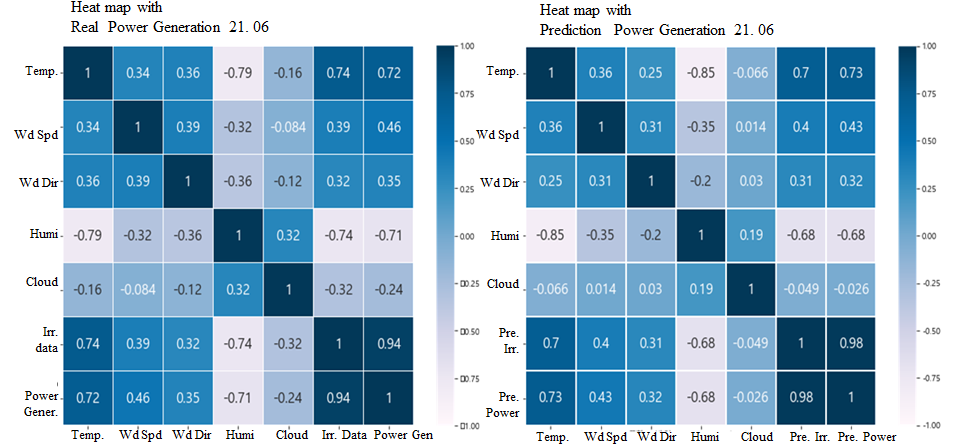
Figure 7. Heat maps of Pearson correlation coefficient comparing meteorological station data with SPV Power amount which is prediction and real in same plant and same